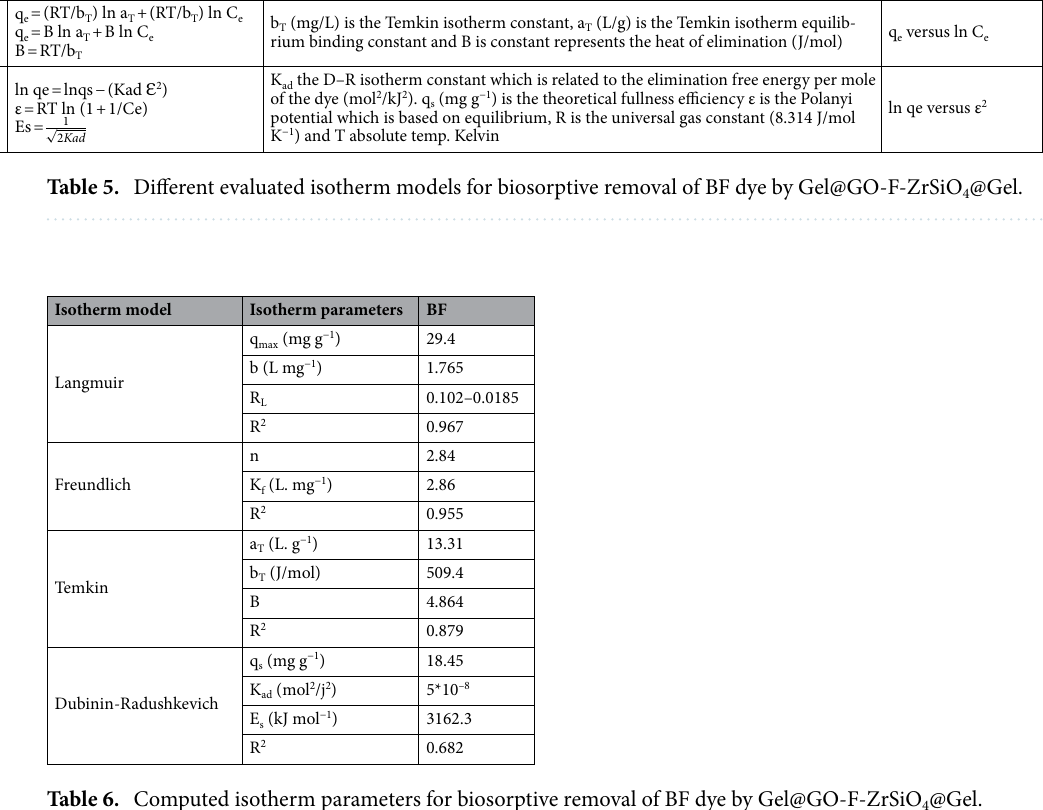
Table 6. Computed isotherm parameters for biosorptive removal of BF dye by Gel@GO-F-ZrSiO 4